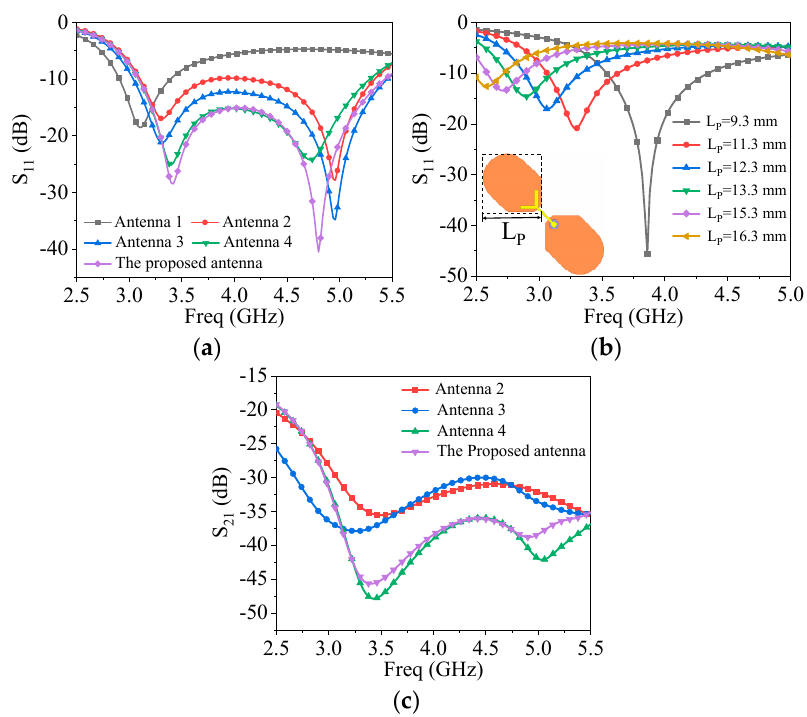
Figure 3. The results of the S-parameters. ( a ) The S 11 of evolution, ( b ) the S 11 of different L P , and ( c ) the S 21 of evolution.